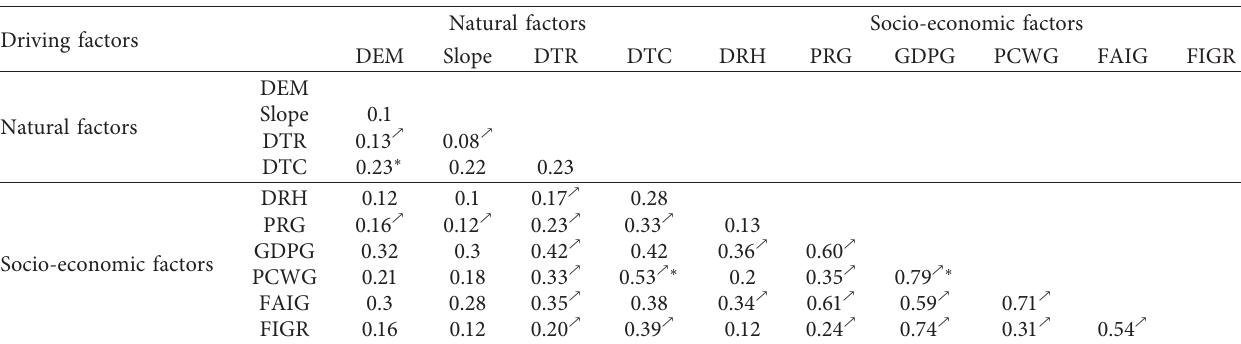
Table 5: Interaction of different factor pairs on urban expansion intensity during 2008–2015.